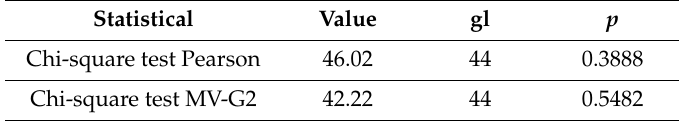
Table 4. Chi square contingency table of education and source of inspiration.